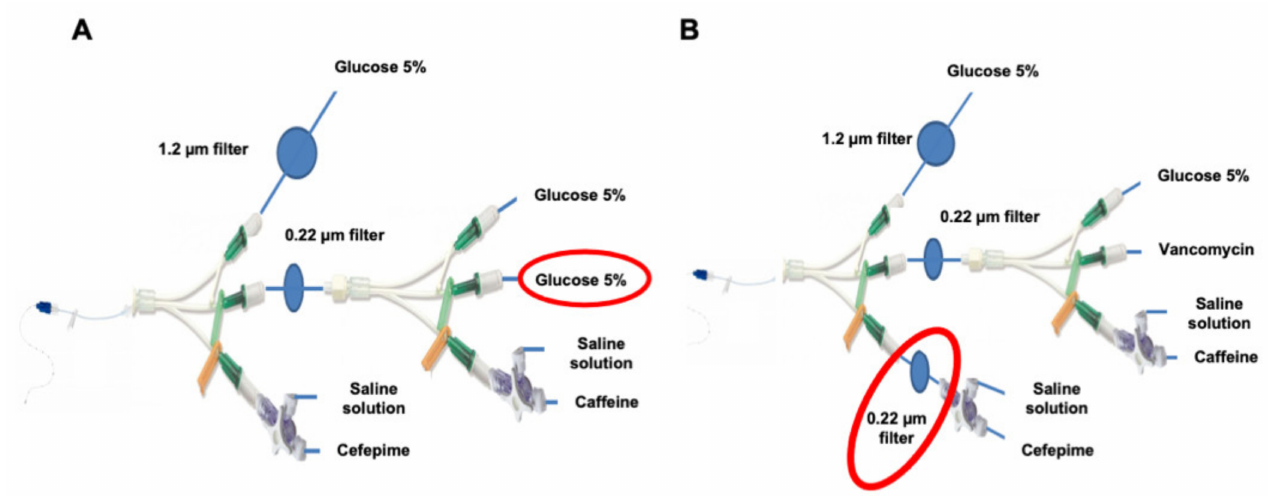
Figure 4. Modified infusion line used in the laboratory. Modified CEF infusion line with replacement of vancomycin infusion by G5% infusion ( A ); Modified CEF infusion line with a 0.22 µ m filter positioned on the emergency route ( B